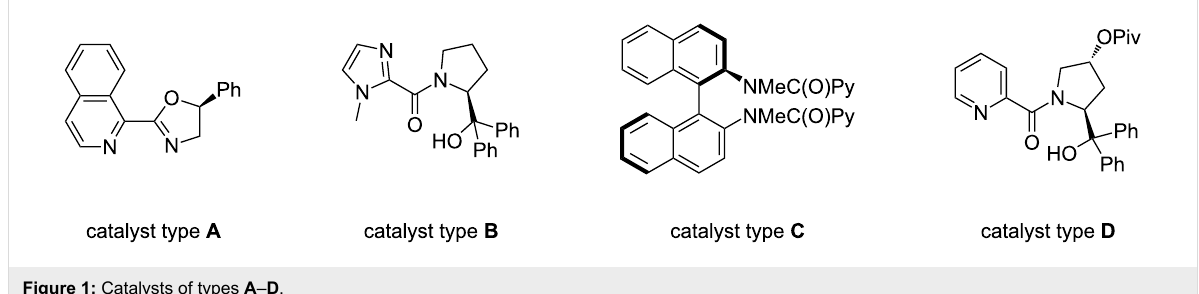
Figure 1: Catalysts of types A – D .